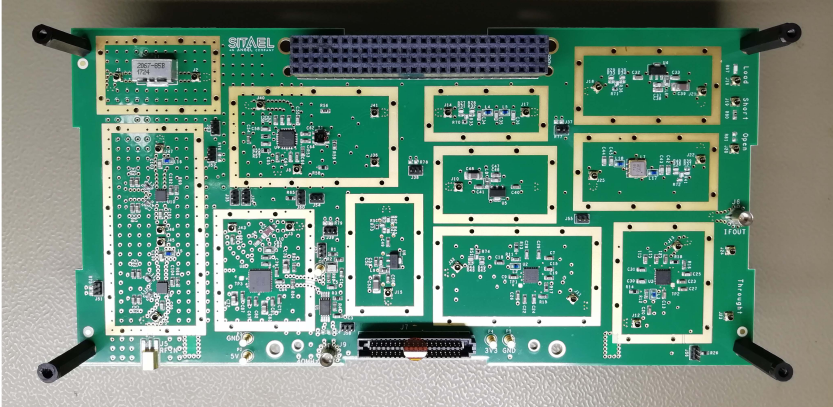
Figure 2. A photograph of the RF receiver prototype.